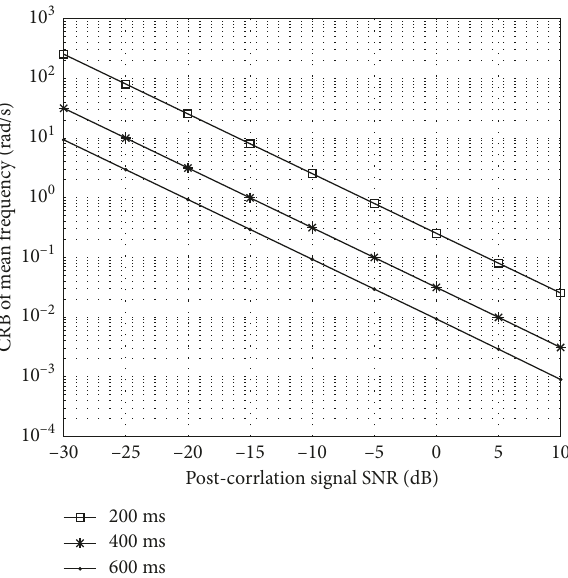
Figure 2: CRB of ω 0 under different integration times.